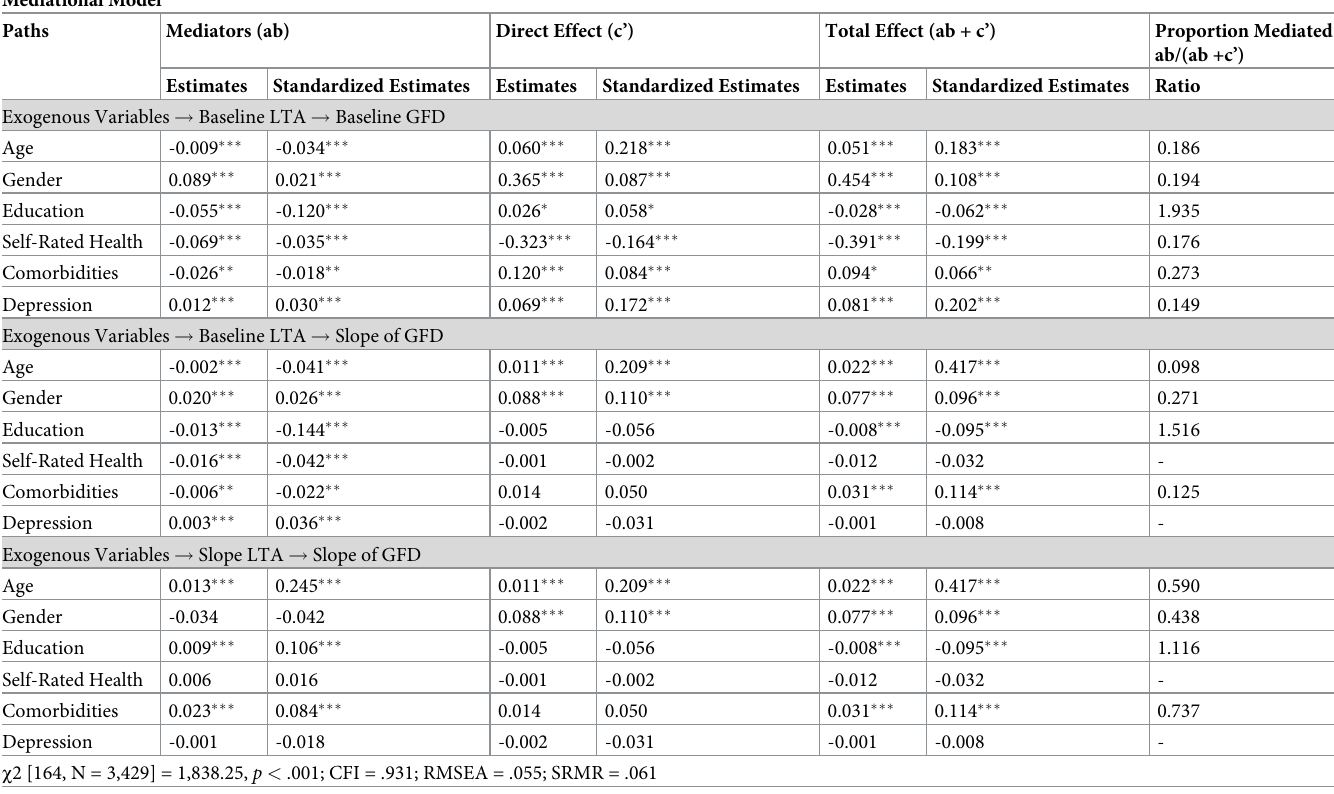
Table 2. Summary of the mediating effects of leisure time activity on general functional disability (N =